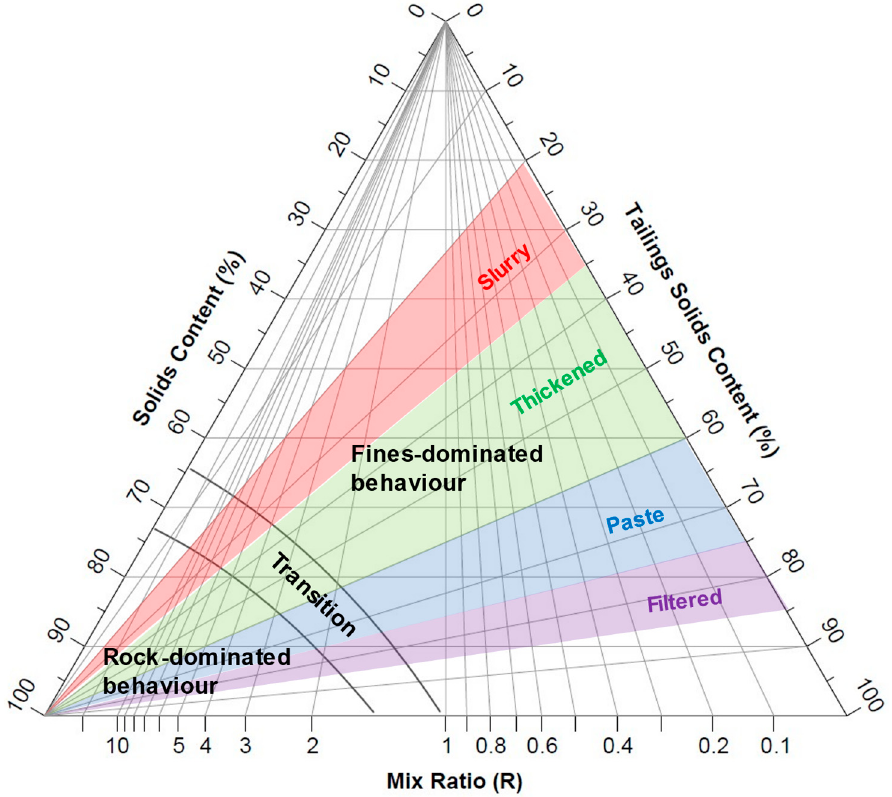
Figure 7. Ternary diagram showing blend configuration vs. mix ratio for different tailings dewatering technologies.